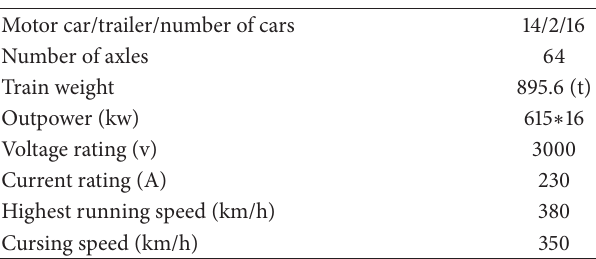
Table 2: Basic train